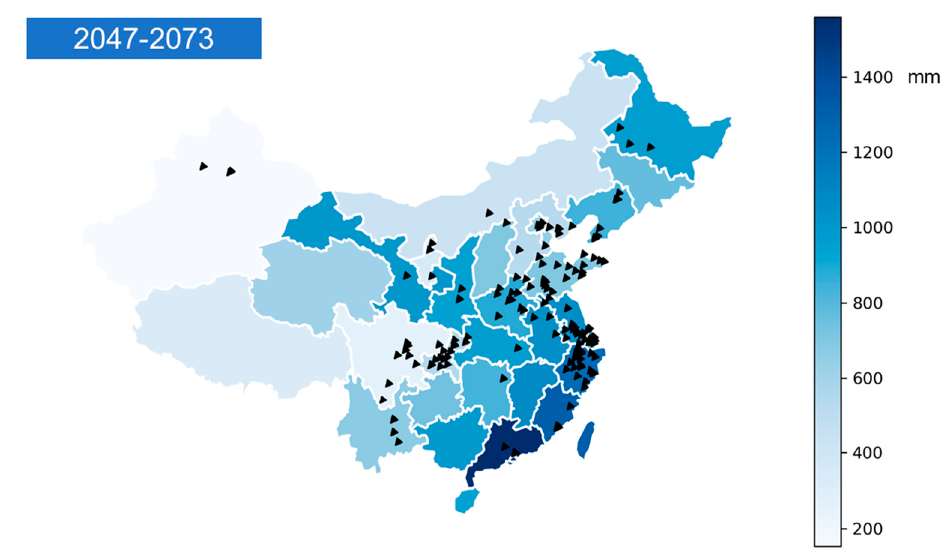
Figure A7. Annual average precipitation levels in mid-term future (2047–2073), and locations of wastewater treatment plants included in the sample.